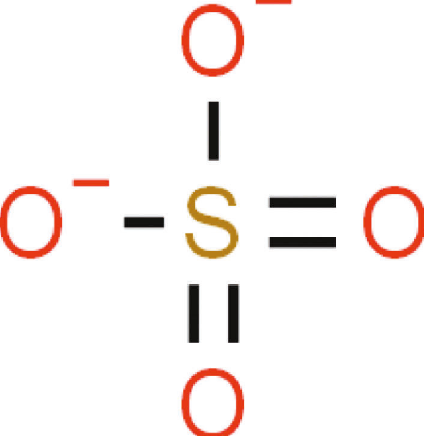
Figure 4: Sulphate ion (Drug identity: DB14546) bound to the peptide sequence GPRYCN.